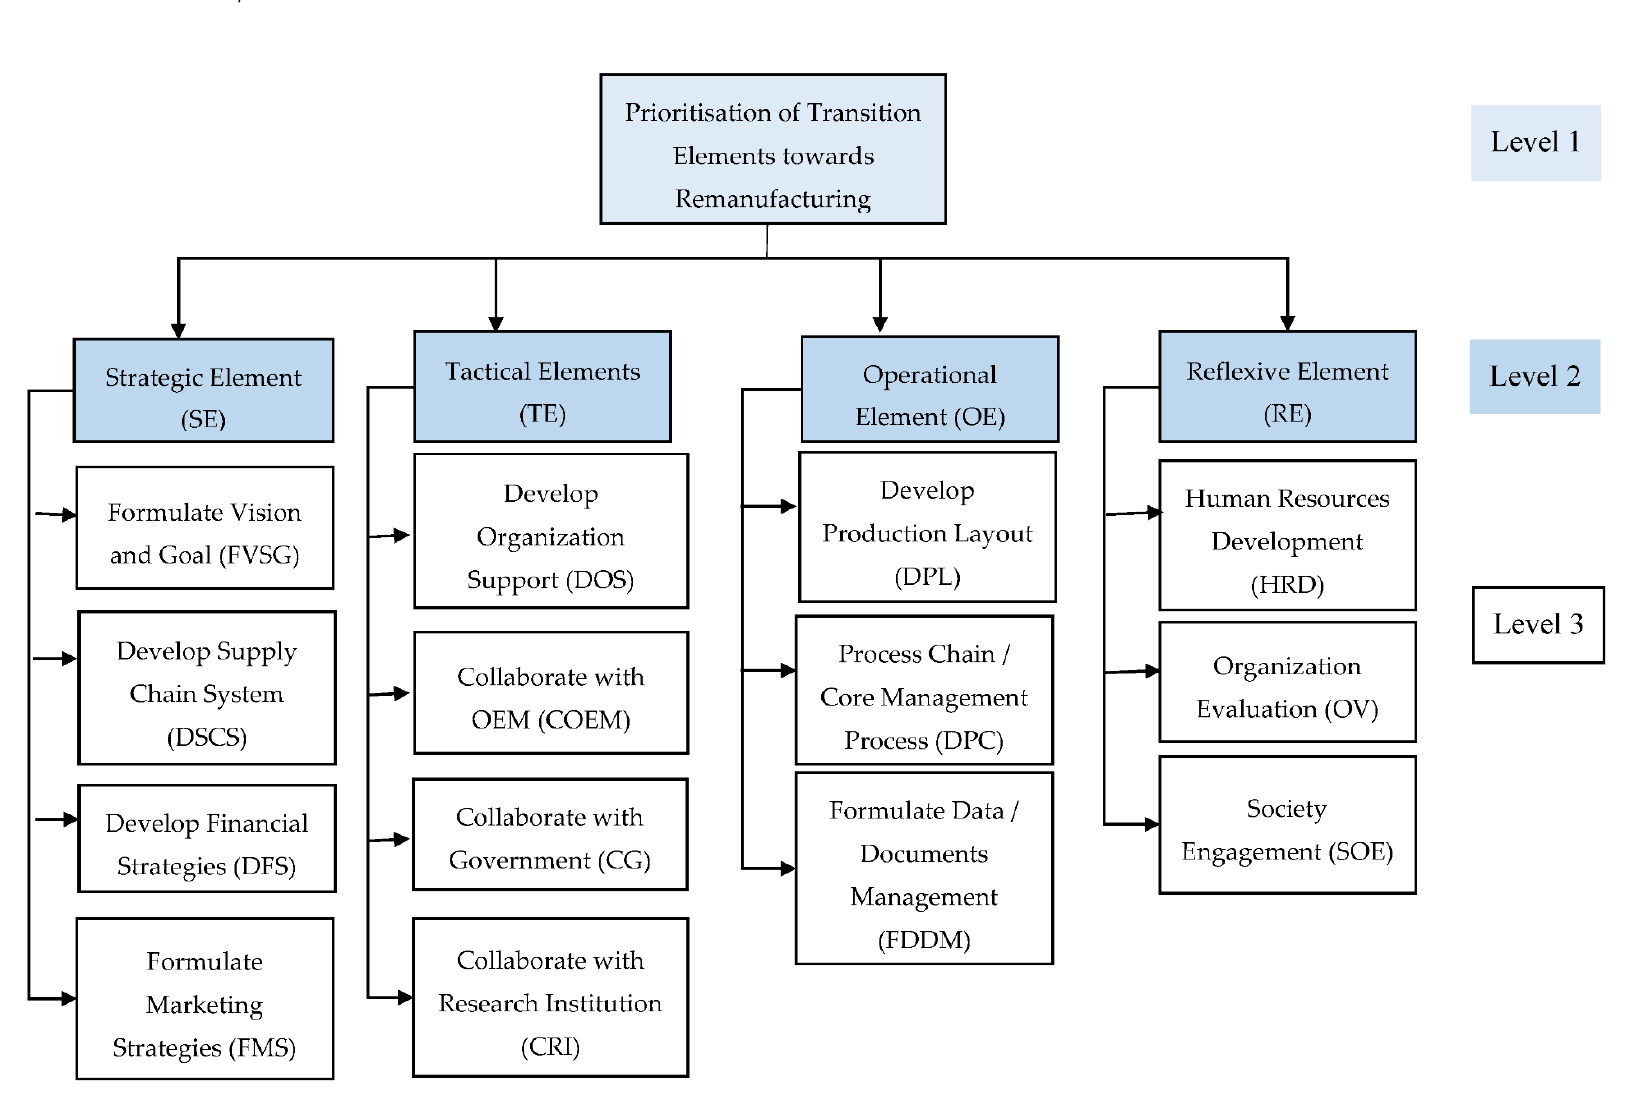
Figure 2. Hierarchal structure of transitional elements .